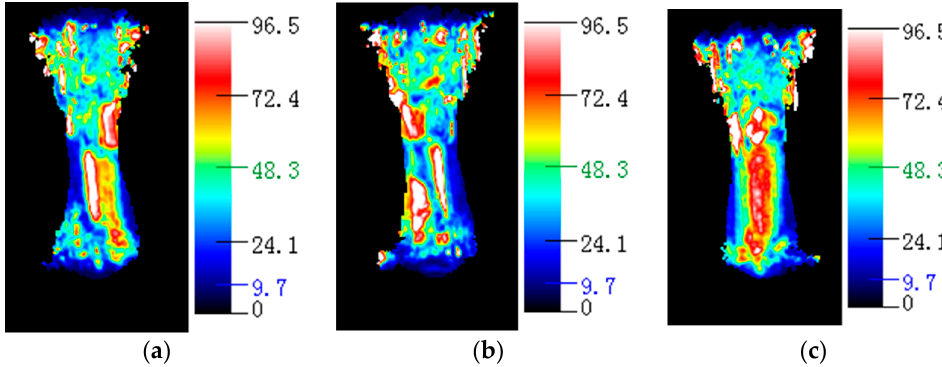
Figure 7. Ultrasonic test results of unidirectional prepreg composites in different emission pressure of the striker. ( a ) 0.3 MPa. ( b ) 0.5 MPa. ( c ) 0.7 MPa.